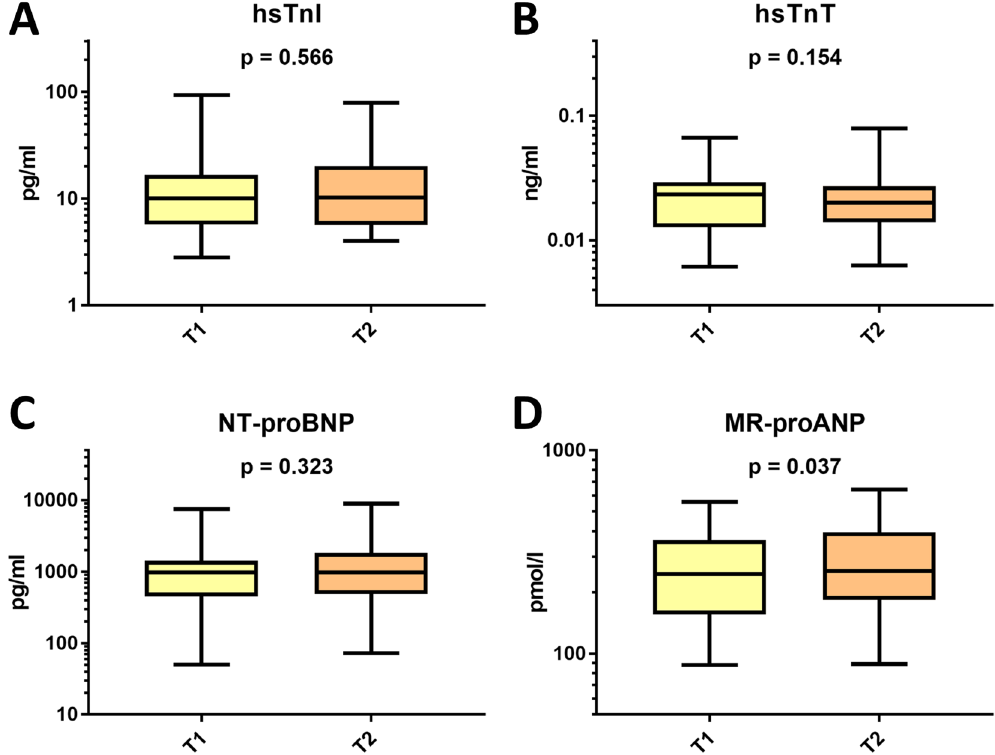
Figure 1. Box plots illustrating changes of the four cardiac reference biomarkers 24 hours prior to (T1) and at mid-term follow-up after (T2) successful percutaneous closure of the LAA (T2): panel A, hsTnT; panel B, hsTnI; panel C, NT-proBNP; panel D, MR-proANP. P < 0.05 indicates statistical significance. Bars indicate medians, boxes indicate 25 – 75. percentiles, and whiskers indicate 5 th – 95 th percentiles .